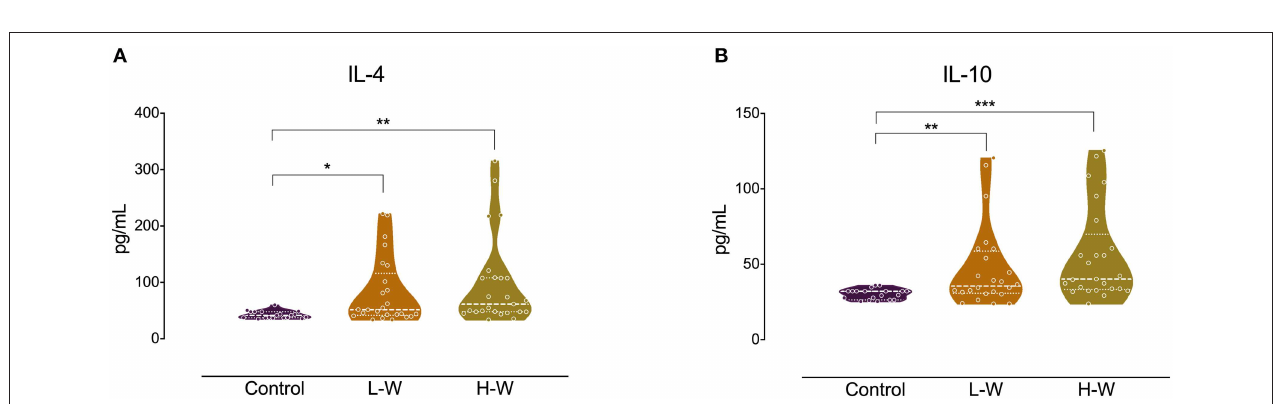
FIGURE 2 | Th-1 cytokines after in vitro stimulation in women with CUD and healthy controls. PBMCs were seeded in 96-well plate and stimulated with phytohemagglutinin (1%) for 72h. Cell supernatants collected from women with CUD showed higher levels of IL-4 (A) and IL-10 (B) than controls. Kruskal–Wallis test was carried out to compare statistical differences. Data are shown as median with interquartile range. Statistical significant group differences are indicated * p < 0.05, ** p < 0.01, and *** p <